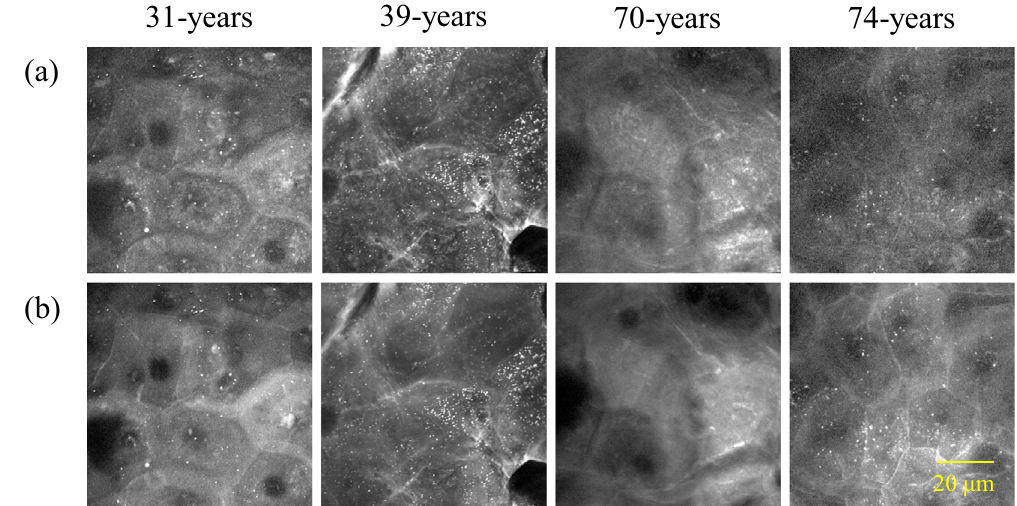
Figure 7. Ambiguous cell outlines in the stratum corneum. Optical cross-section images at ( a ) 2850 cm − 1 and ( b ) 2930 cm − 1 of different-aged